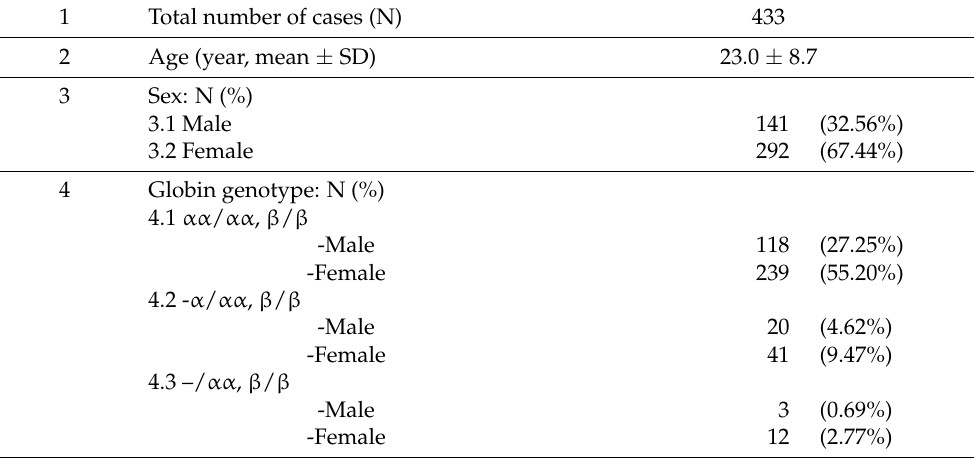
Table 1. Demographic data of participant subjects of this